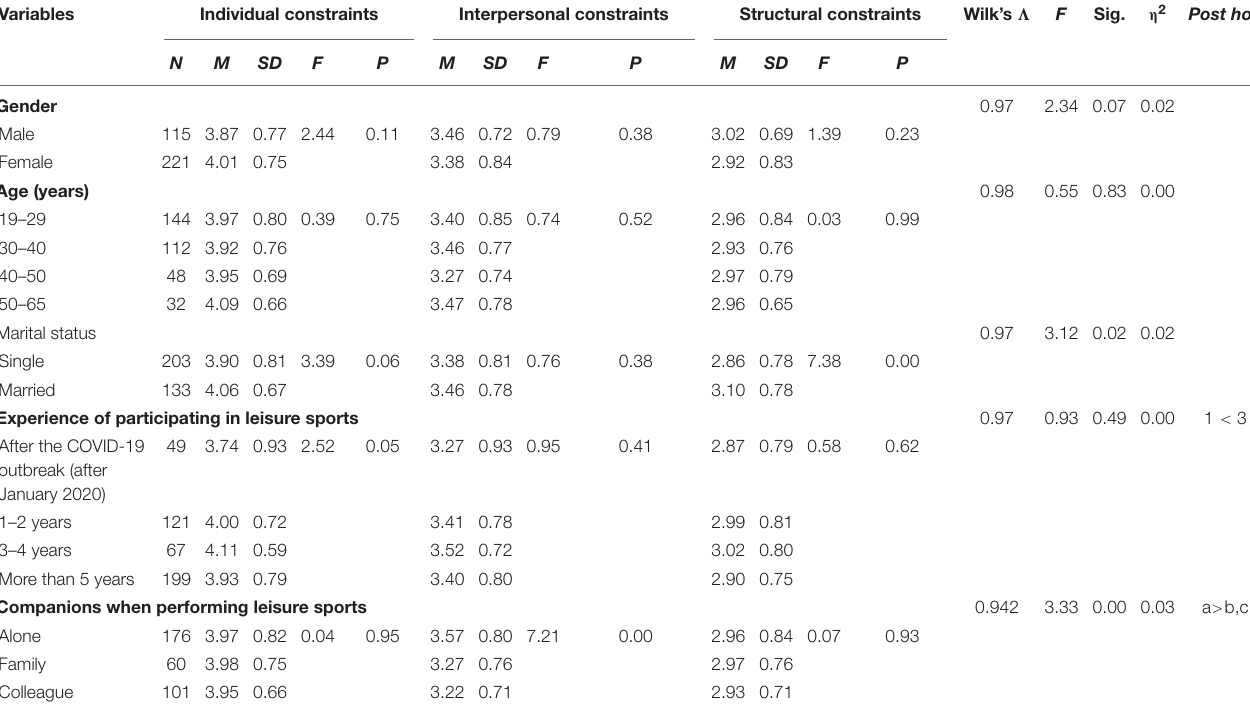
TABLE 5 | Differences in the leisure constraints of indoor leisure sports participants in terms of demographic characteristics ( N = 336). Variables Individual